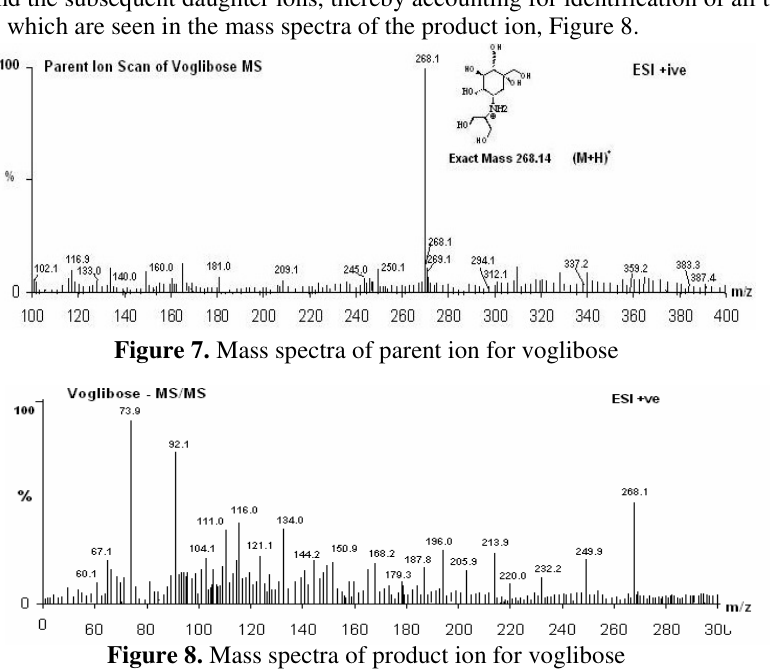
Figure 8. Mass spectra of product ion for